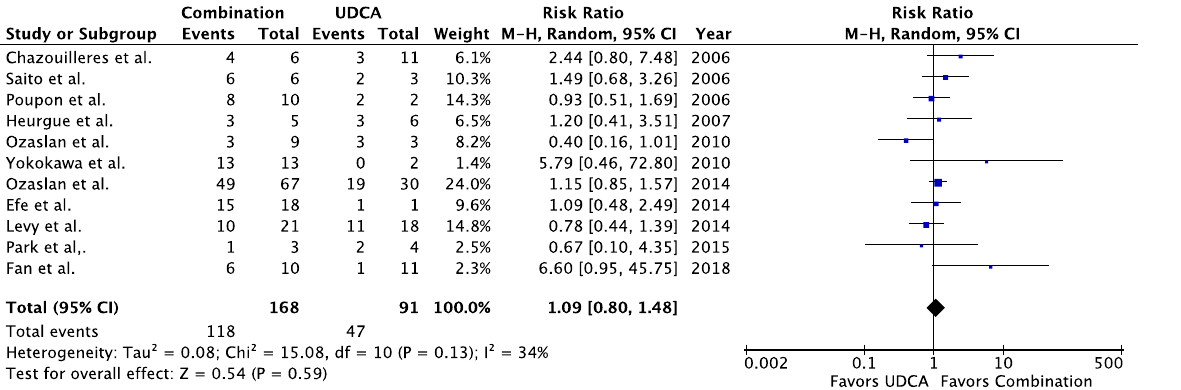
Figure A3. Biochemical improvement in AIH-PBC patients treated with combination therapy vs. UDCA alone, including only those studies in which AIH-PBC was defined by the Paris criteria. UDCA = ursodeoxycholic acid, Combination = UDCA + [corticosteroids and/or antimetabolites].